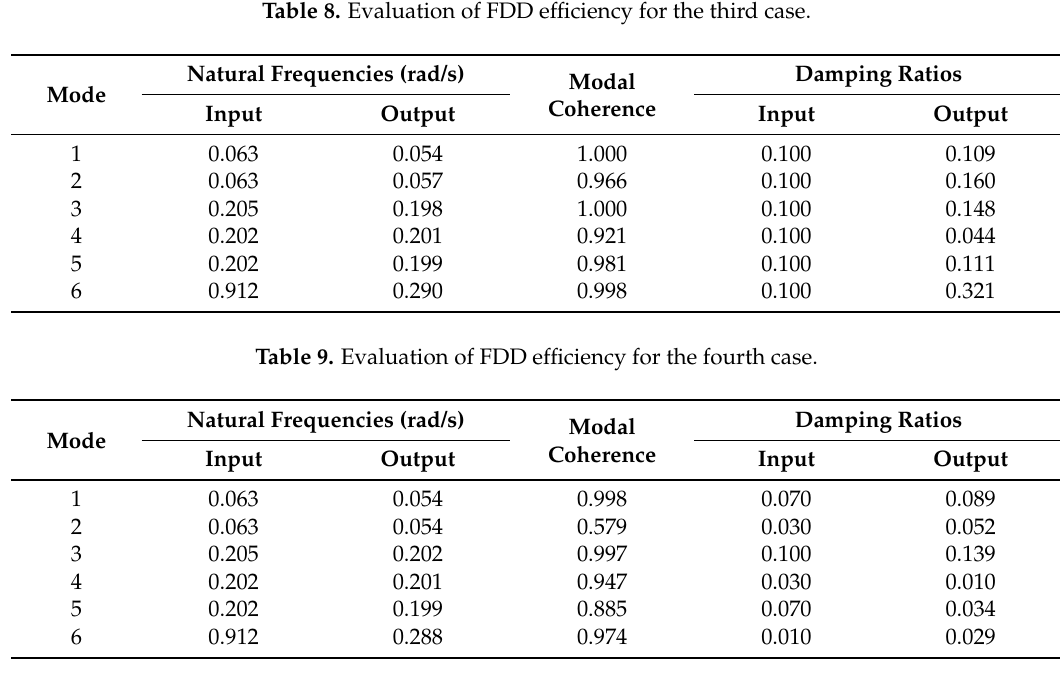
Table 8. Evaluation of FDD efficiency for the third case.